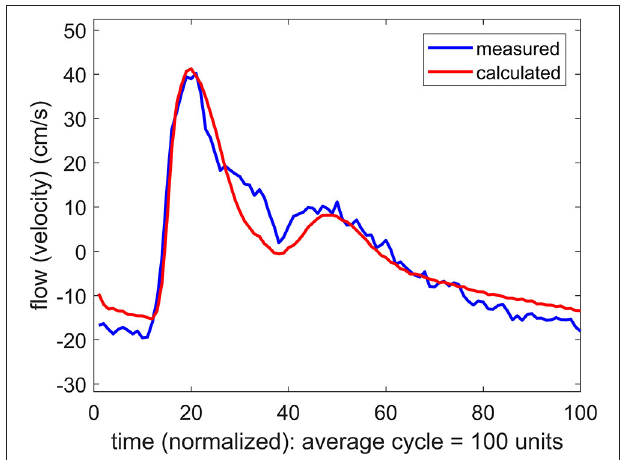
FIGURE 4 | Comparison of measured and calculated flow (velocity) waveforms in the cerebral vascular bed, the latter being based on systemic pressure waveform measured simultaneously at the brachial artery, as in Figure 3 , but here the pressure is shifted in time by 40 ms.